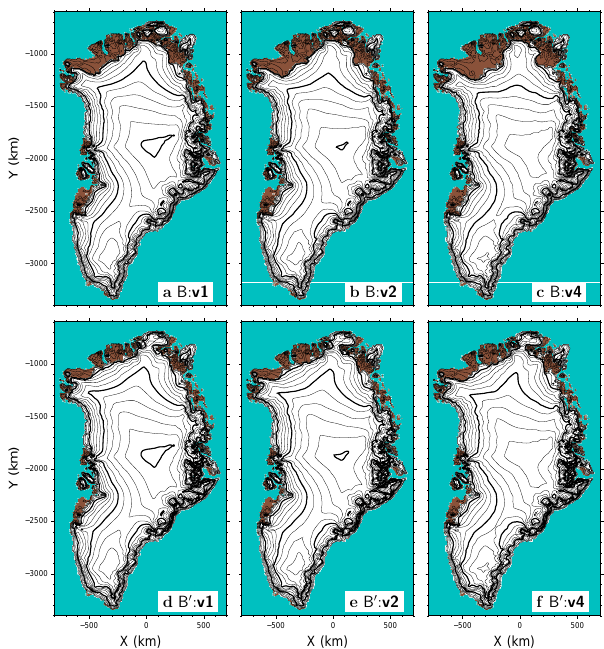
Figure 3. Simulated present-day surface topography obtained by experiments with free spin-up initialization and sub-melt sliding: B (upper panels) and B (cid:48) (lower panels). Contour intervals are 200 and 1000m for thin and thick lines,